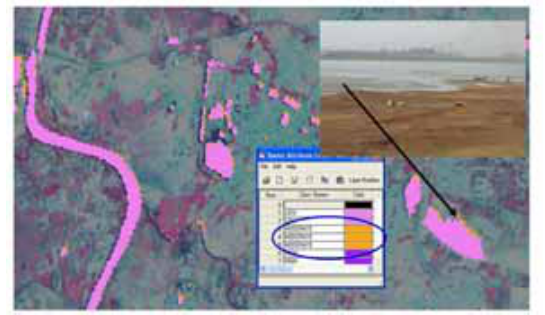
Figure 3. Turbidity Level of Maroda Tank, Durg